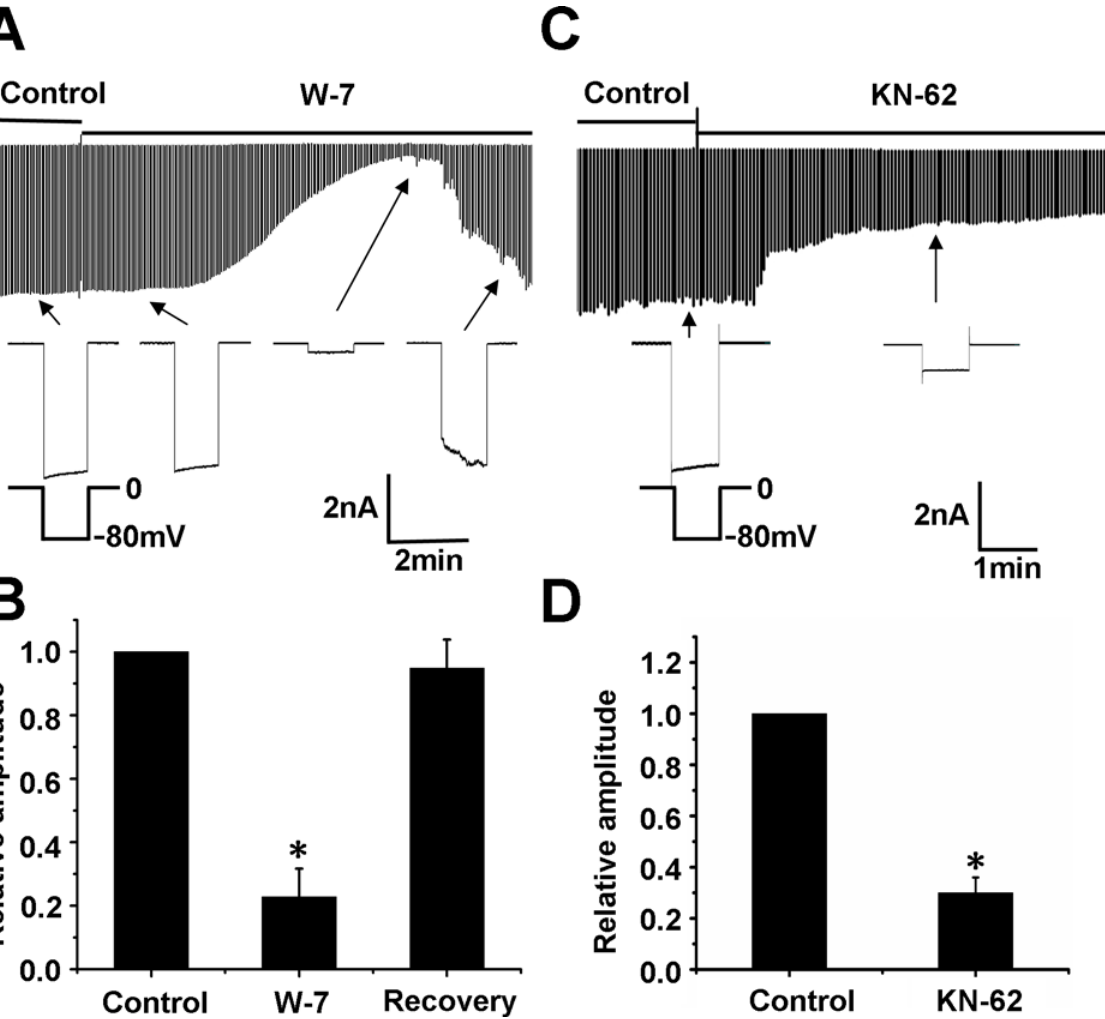
Fig 7. The effects of CaMKII on these currents. (A) W-7 (100 μ M) strongly suppressed the Kir currents. The channel inhibition took place rapidly within 1 min after the exposure, lasted for a short period (1 – 2 min), and then became desensitized. (B) Quantitatively, W-7 inhibited the currents by 77.2 ± 0.1% (n = 9). The channel inhibition was recovered by 94.84% in 5.7 ± 2.1 min after application of W-7 (n = 9). (C) CaMKII inhibitor KN-62 (10 μ M) suppressed the Kir currents after PAECs were exposed for 1.5 min and the inhibition was not recovered. (D) Quantitatively, KN-62 inhibited the currents by 71 ± 0.1% (n = 5). * P < 0.05 versus